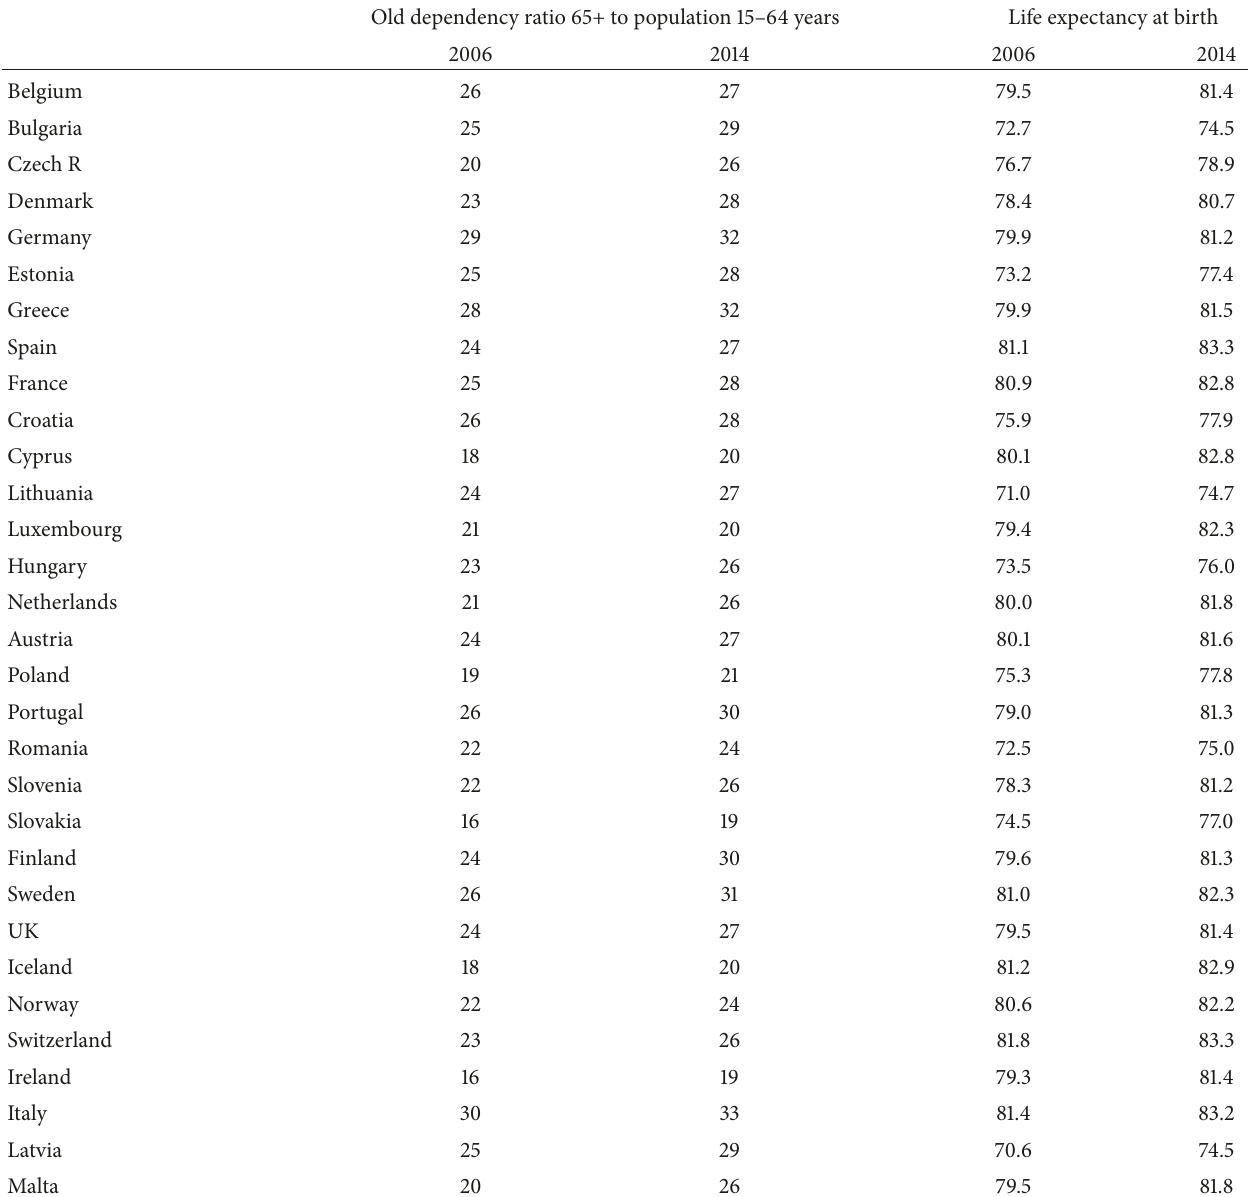
Table 2: Mean scores on the demographic indicators old dependency ratio and life expectancy at birth per country in 2006 and